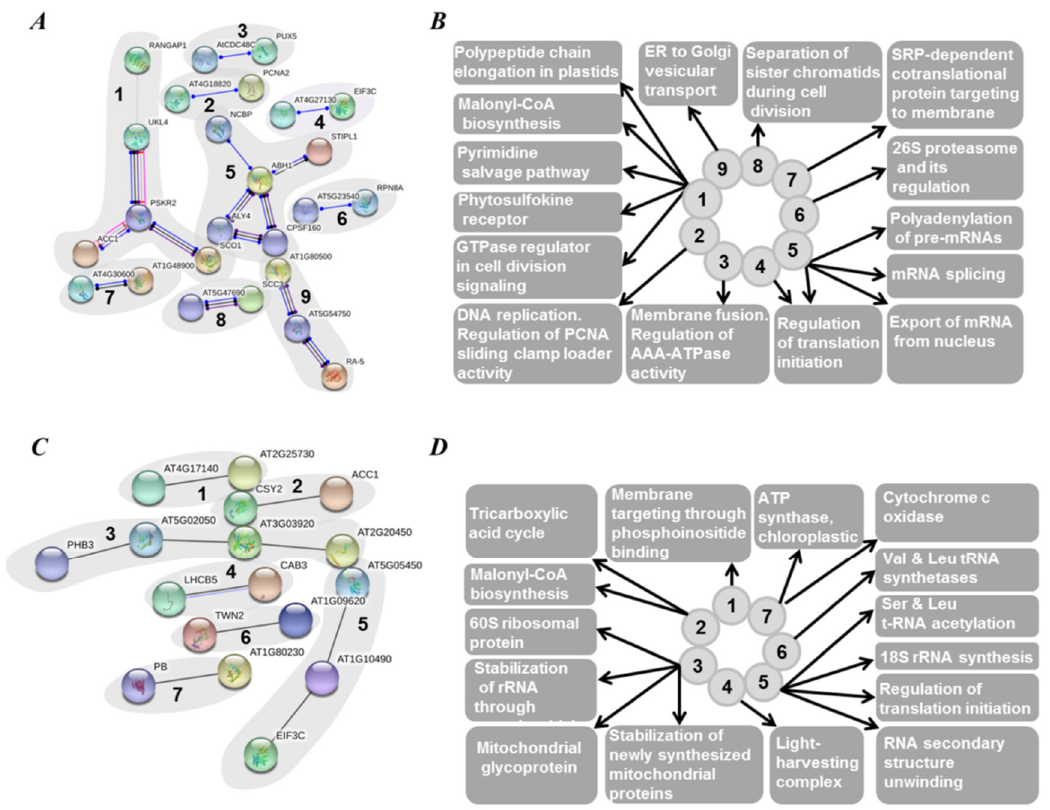
Figure 8. String database analysis (https://string-db.org/) of interaction networks formed by proteins, unique for green seeds (cultivar Gloriosa). The networks ( A , C ) and related functional pathways ( B , D ) relied on experimentally derived functional and/or structural evidences ( A , B ) and coexpression data ( C , D ) with interaction score ≥ 0.7 (corresponded to highly confident entries). Color coding of interactions: black, reaction; blue, binding; light blue, phenotype; green, activation; purple, catalysis; red, inhibition; pink, posttranslational modifications (PTMs); yellow, transcriptional regulation. Filled and empty nodes denote proteins with known and unknown structure, respectively. Detailed description of protein data is provided in Supplementary information 7.